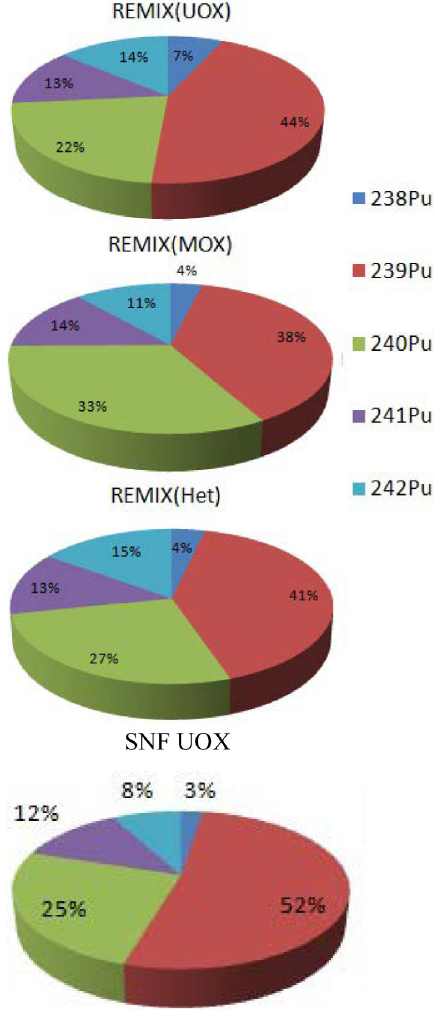
Fig. 8. The close to the equilibrium Pu isotopes con fi guration for fresh fuel compositions in comparison with plutonium in SNF from UOX fuel,